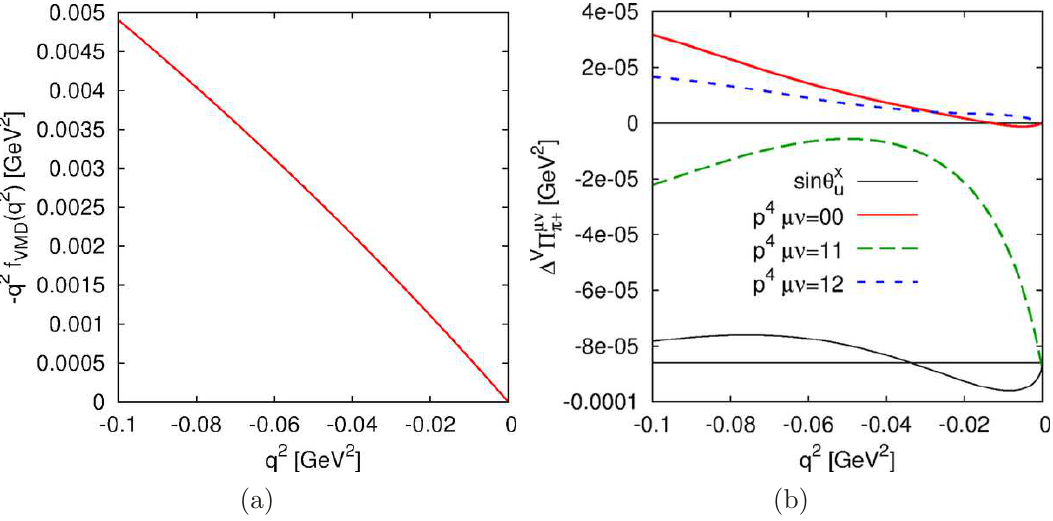
Figure 4 . (a) q 2 f VMD ( q 2 ) as a function of q 2 . This together with (7.4) and (7.5) can be used − to judge the relative size of the finite volume effects in the following figures. (b) The finite volume corrections at p 4 for the spatially symmetric case. The lower straight line indicates zero around which sin θ x oscillates. u